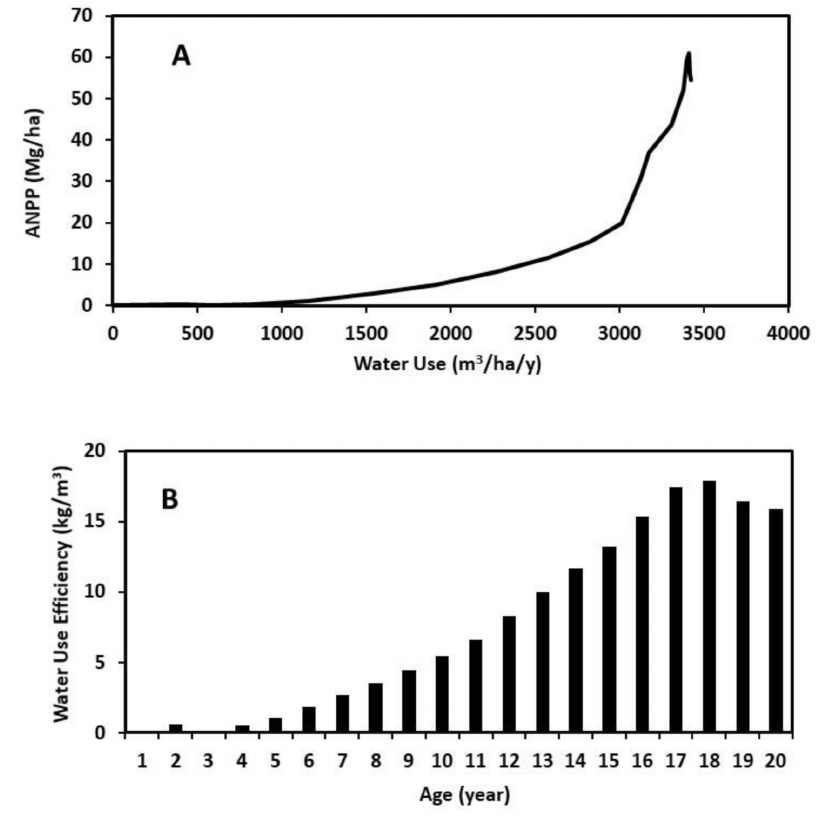
Figure 7. ANPP as a function of water use ( A ) and WUE as a function of eucalyptus age ( B ).